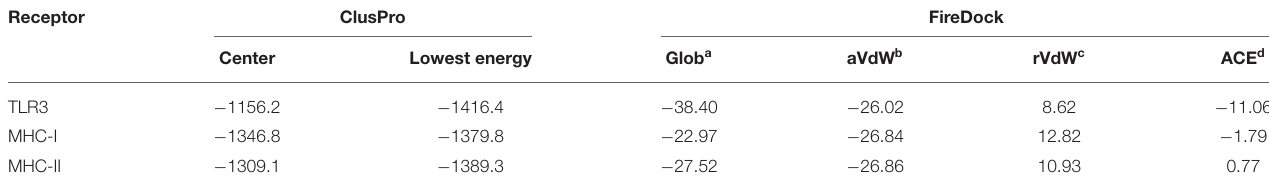
TABLE 6 | Molecular docking of final vaccine constructs with TLR3, Mda5, and MHC-II. Receptor ClusPro FireDock Center Lowest energy Glob a aVdW b rVdW c ACE d TLR3 − 1156.2 − 1416.4 − 38.40 − 26.02 MHC-I − 1346.8 − 1379.8 − 22.97